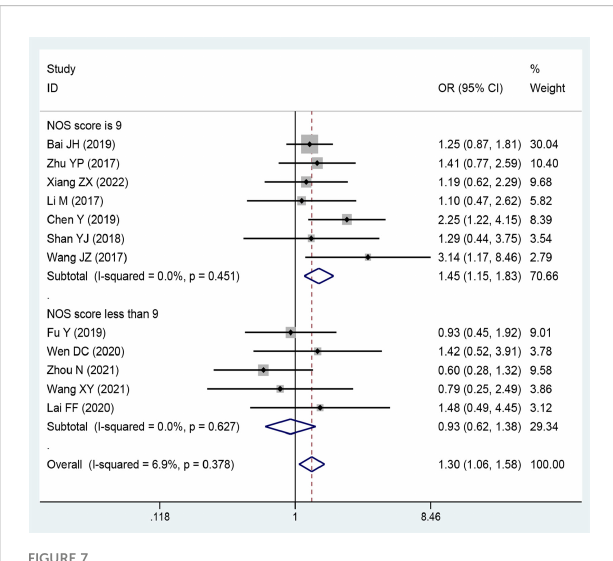
FIGURE 7 Forest plot showing the relationship between small nucleolar RNA host gene (SNHG) expression and tumor size stage in colorectal